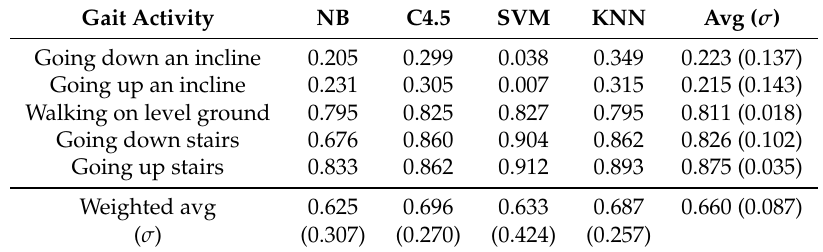
Table 2. F-measures for all gait activities using the best treatment by each classifier from unbalanced data (Table 1).